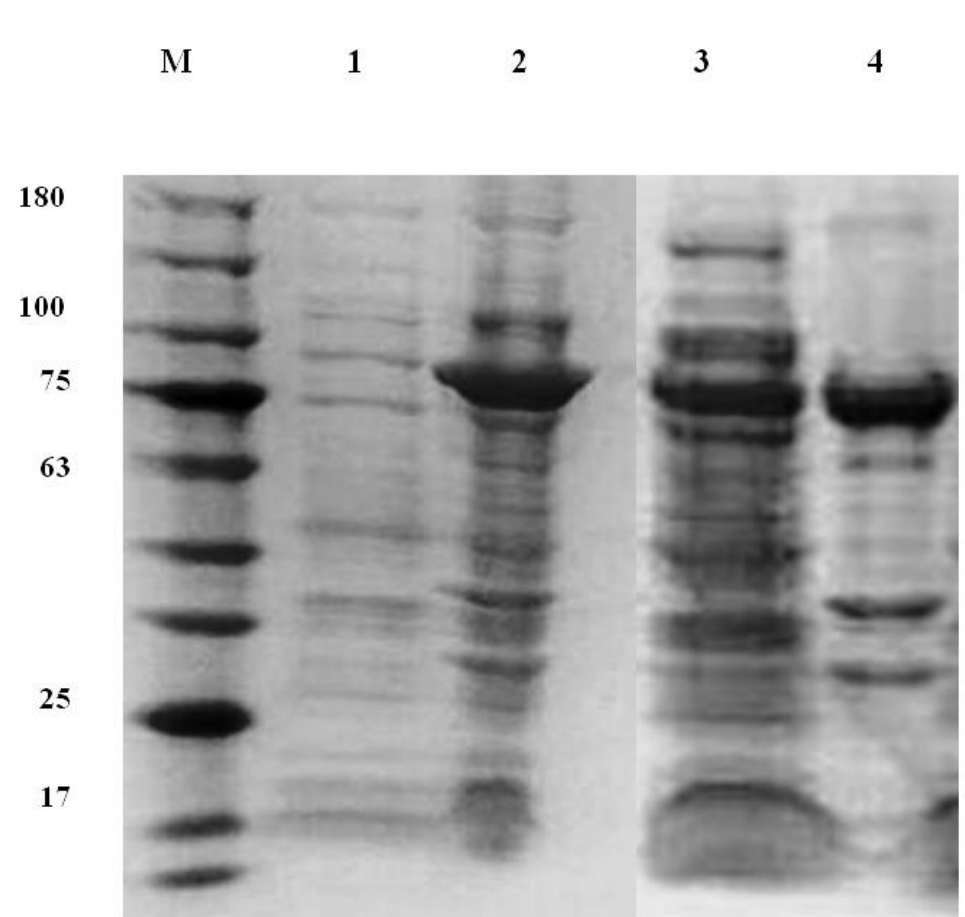
Figure 1. SDS-polyacrylamide gel electrophoresis of chitinase 1198 from recombinant E. coli . M, molecular mass; Lane 1, cell lysate of E. coli before IPTG (isopropylthio- β -galactoside) induction; Lane 2, cell lysate of E. coli after IPTG induction for 7 hours; Lane 3, supernatant; Lane 4, precipitation of E. coli lysate after sonication and centrifugation.